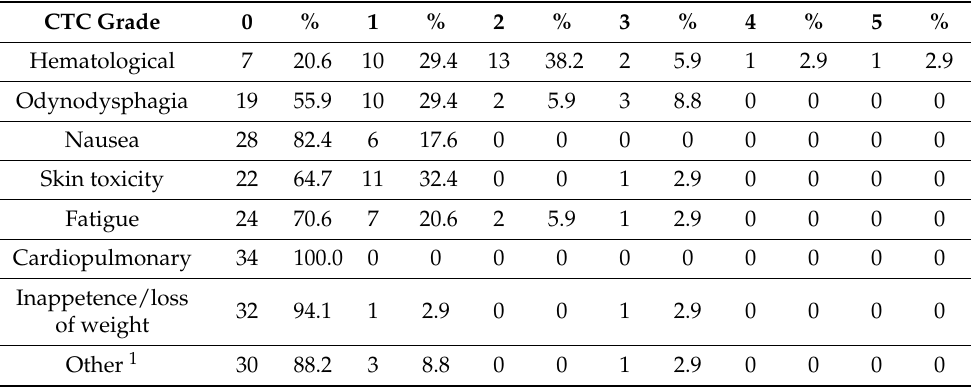
Table 3. Acute treatment related toxicities according to Common Terminology Criteria for Adverse Events (CTCAE, v5.0), absolute number of patients (n = 34).